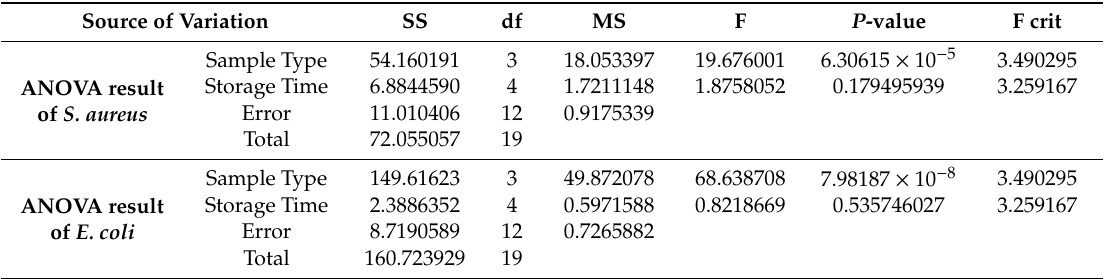
Table A1. ANOVA analysis of antimicrobial test result over storage time: control wipe samples. Source of Variation SS df MS F crit ANOVA result of S. aureus